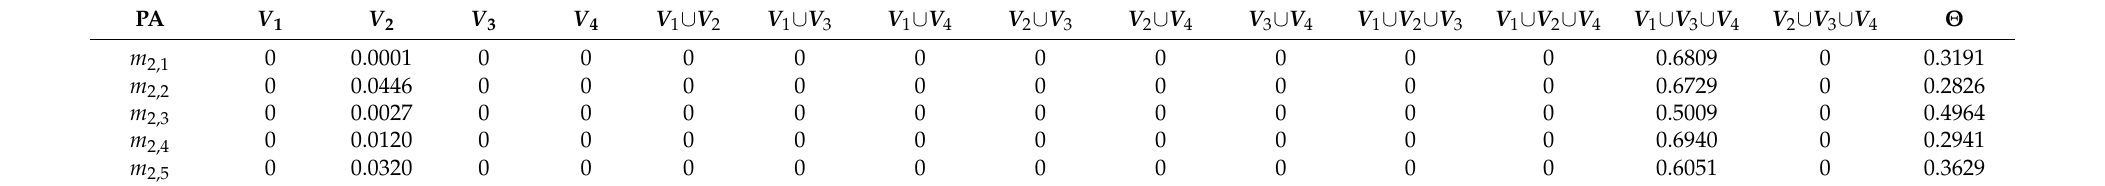
Table 3. Probability assignments of longitudinal crack-rest sub-classifier for an image without a crack.